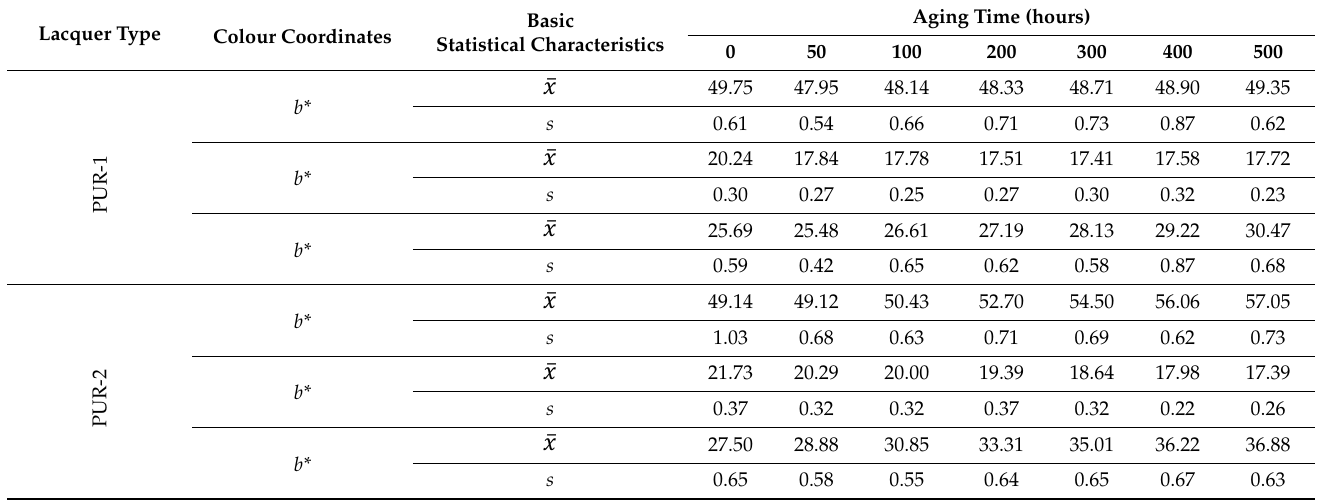
Table 3. Basic statistical characteristics of colour coordinates L * , a * , and b * corresponding to different phases of the accelerated aging process of spruce wood surface-treated with polyurethane lacquers. (The number of measurements for each set n = 50.)